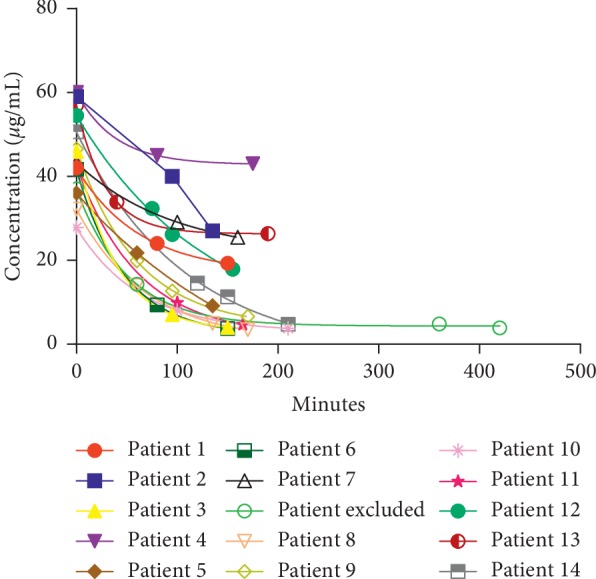
Plasmatic meropenem concentration decay curves.